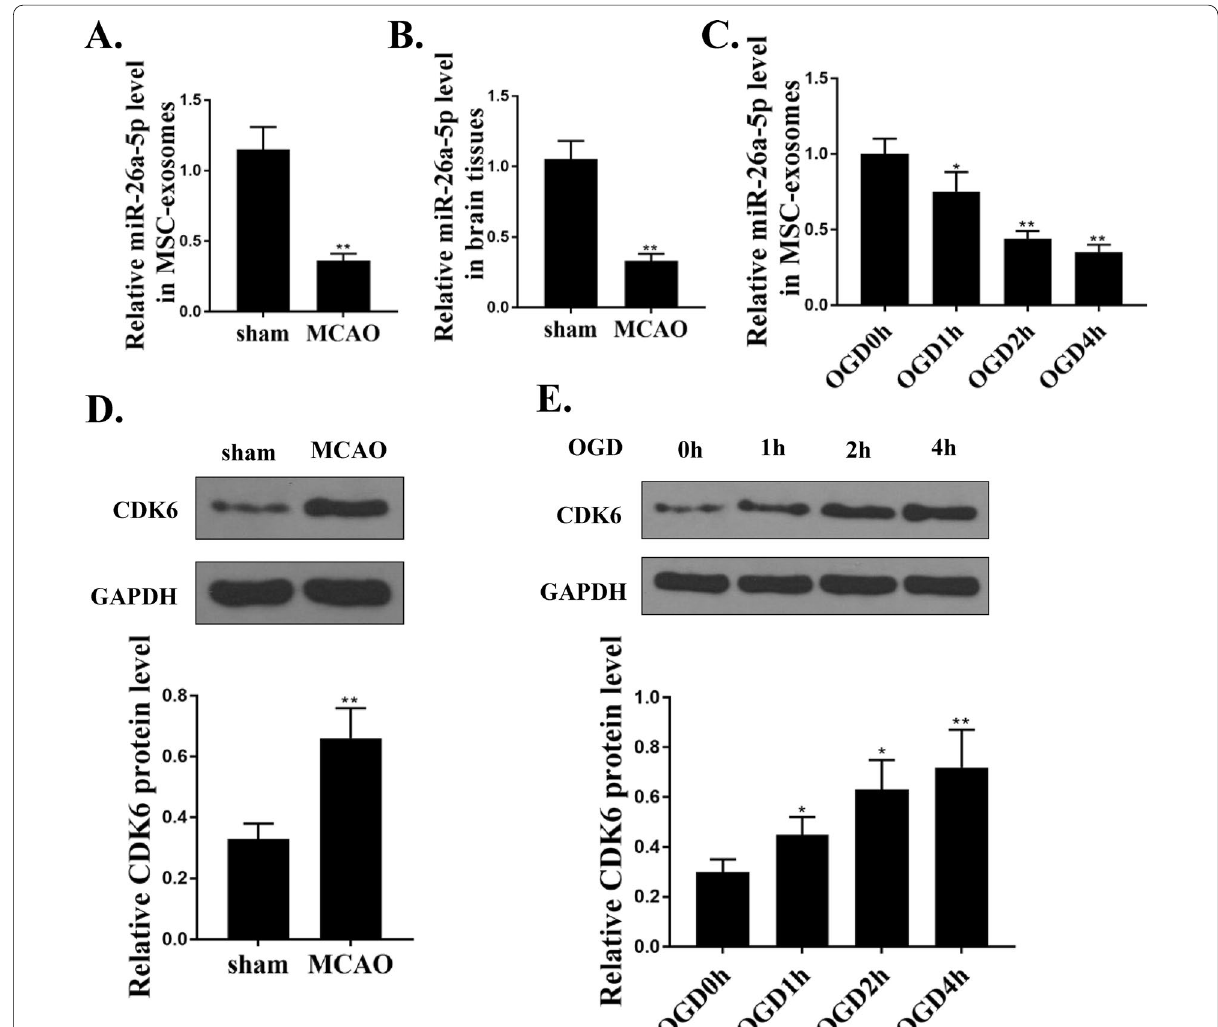
expression of miR-26a-5p in MSCs-derived exosomes ( A ) and brain tissues ( B ) of MCAO-induced mice was evaluated by qRT-PCR. C The level of miR-26a-5p in exosomes of OGD-treated MSCs at indicated time was evaluated by qRT-PCR. D The protein expression of CDK6 in MSCs-derived exosomes of MCAO-induced mice was evaluated by western blot. E The protein expression of CDK6 in exosomes of OGD-treated MSCs at indicated time was evaluated by western blot. *p < 0.05, **p <